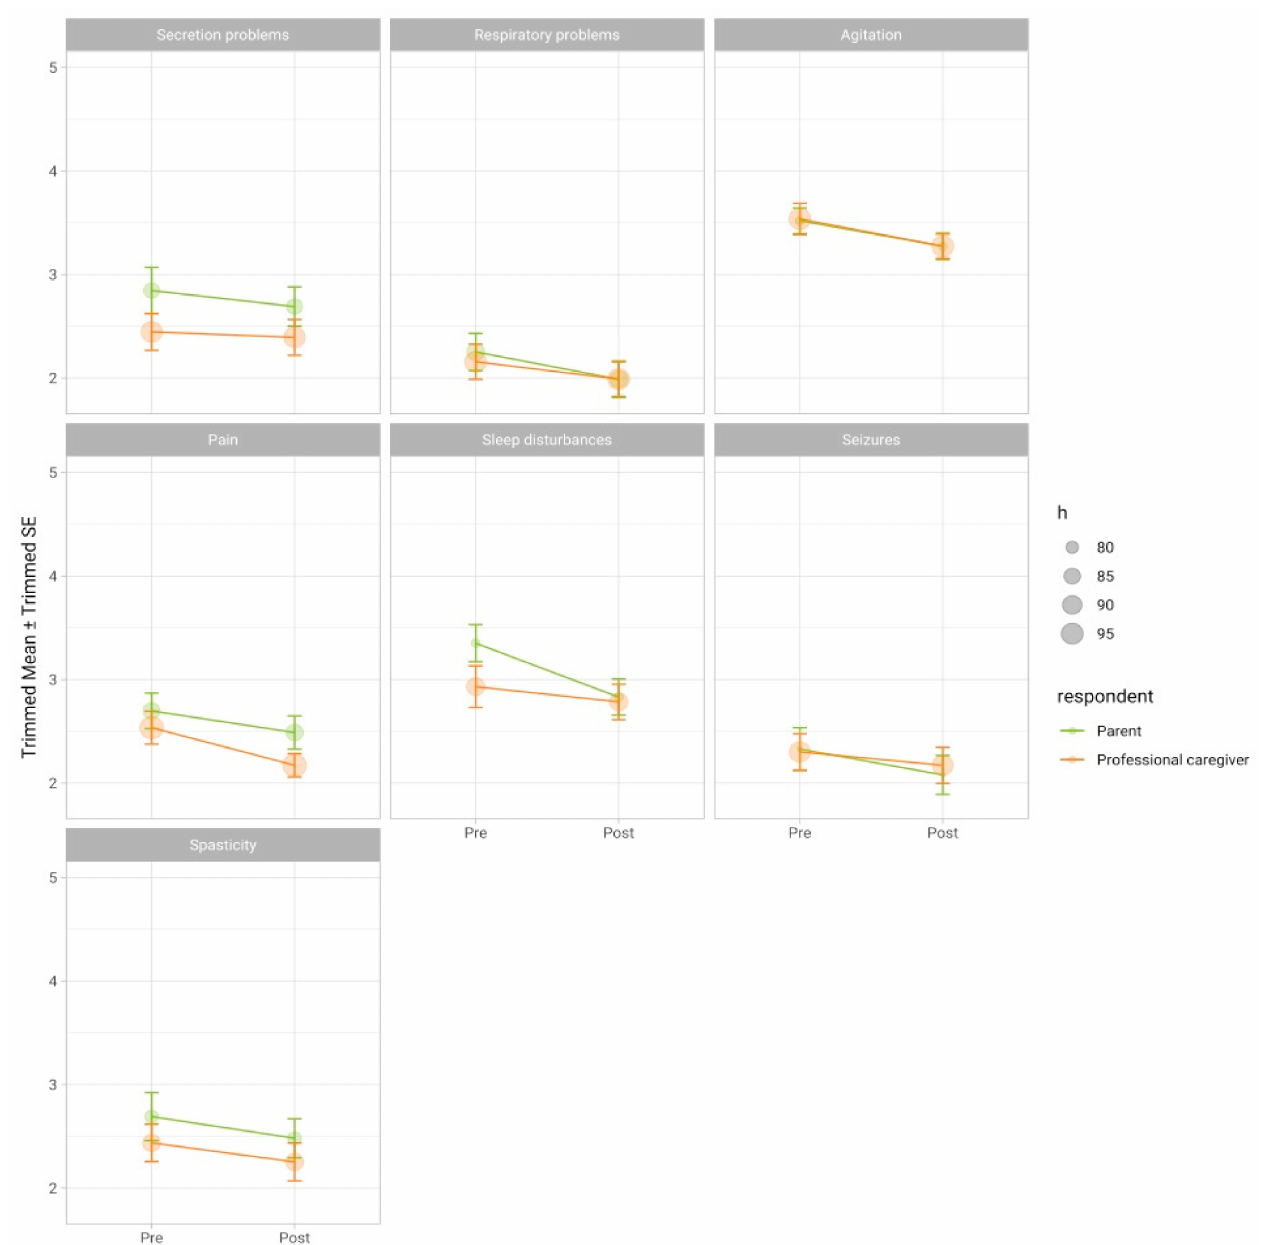
Figure 1. Trimmed mean and standard deviation of the individual symptoms assessed through parents and professional caregivers at admission (Pre) and discharge from an inpatient setting or two months after admission to an outpatient setting (Post); h constitutes the sample size after